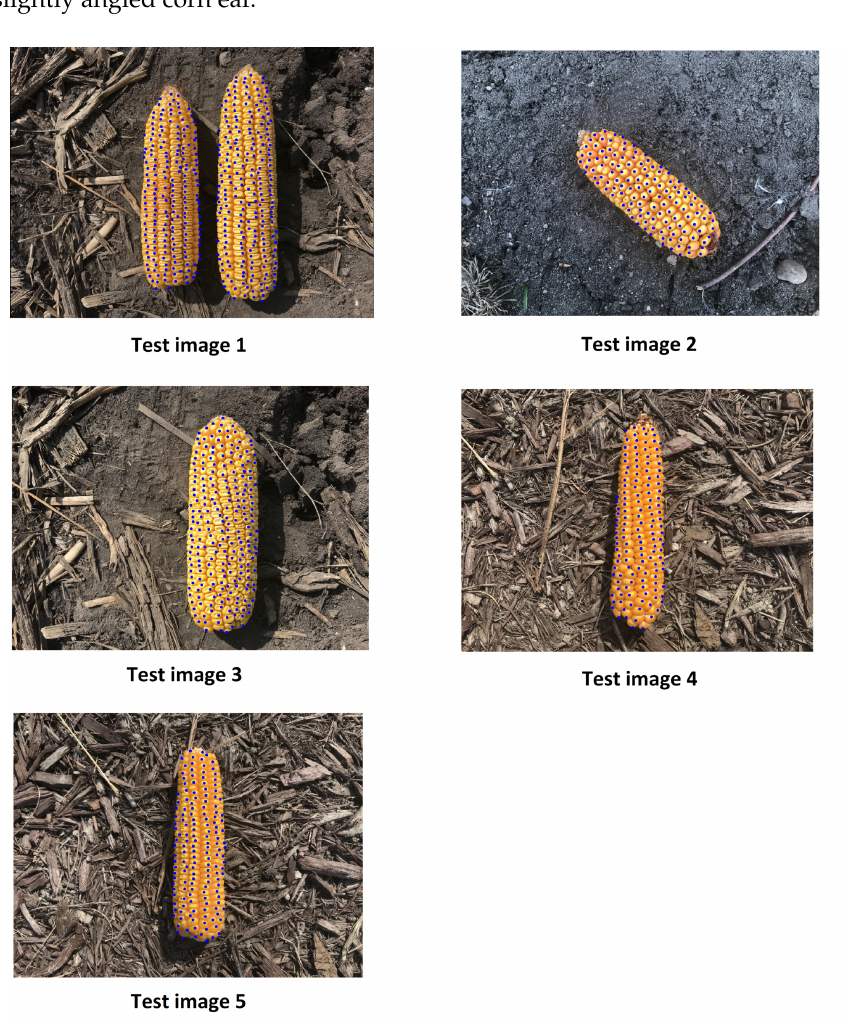
Figure 8. The results of the proposed approach on 5 different test